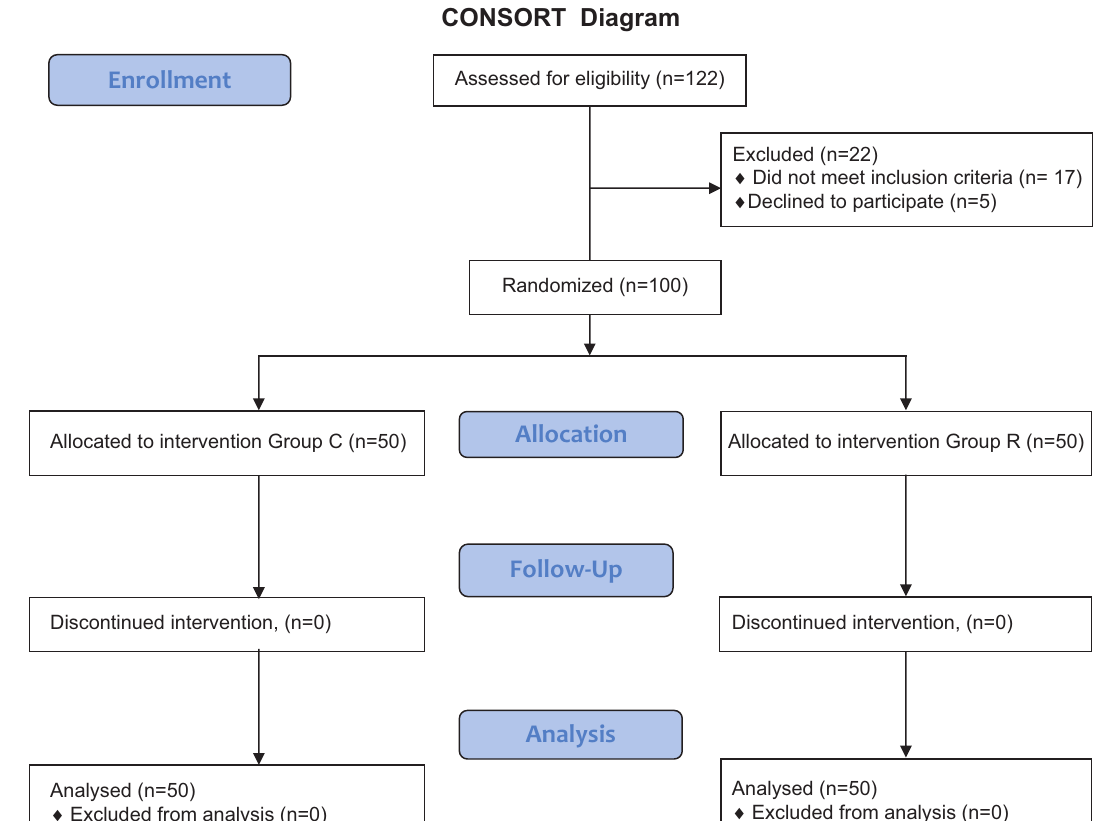
Figure 2. Consolidated standards of reporting